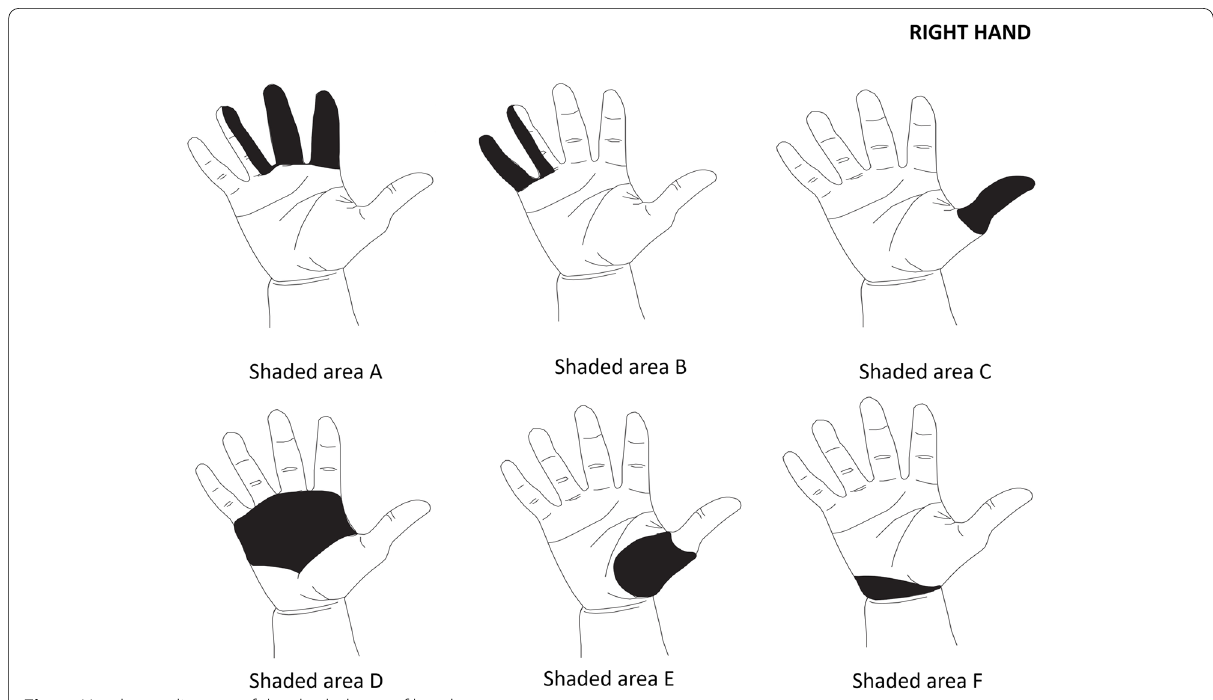
Fig. 1 Hand map diagram of the shaded area of hand